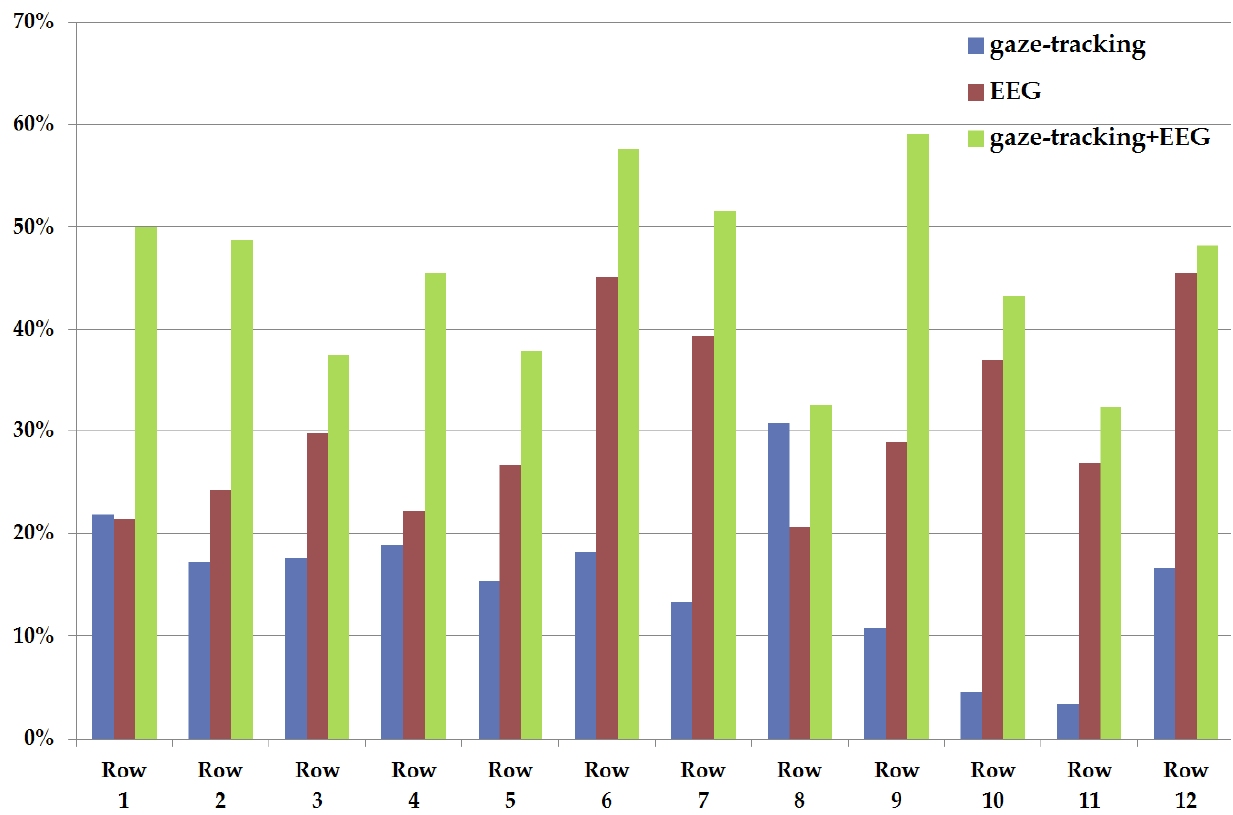
Figure 7. Comparisons of vertical